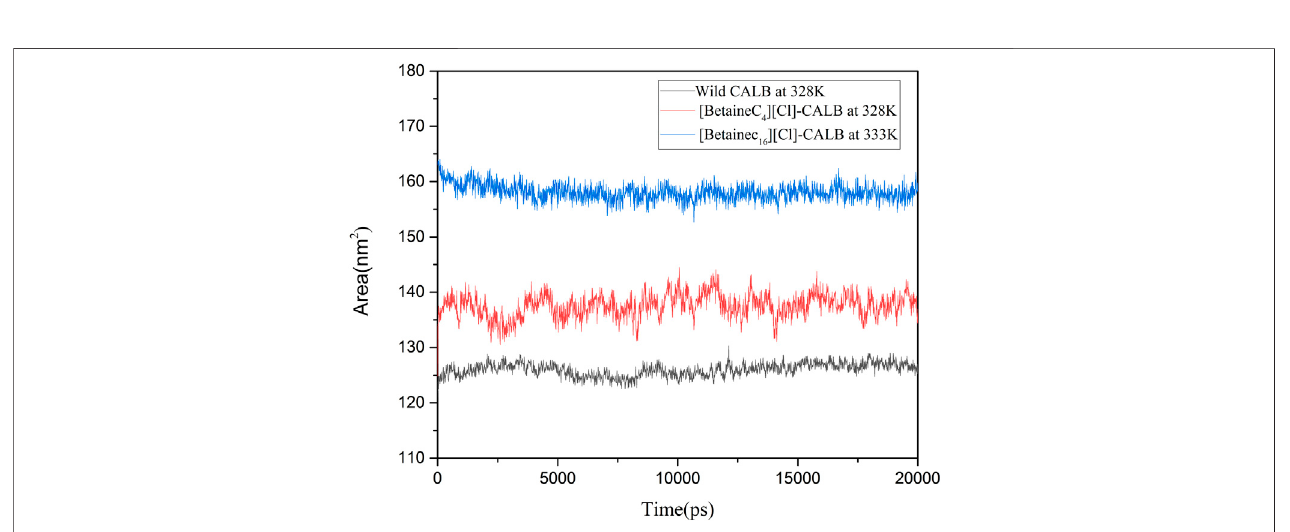
FIGURE 10 | The hydrophobic and hydrophilic area of native and modi fi ed CALB using the examples of [BetaineC 4 ][Cl]-CALB and [BetaineC 16 ][Cl]-CALB.